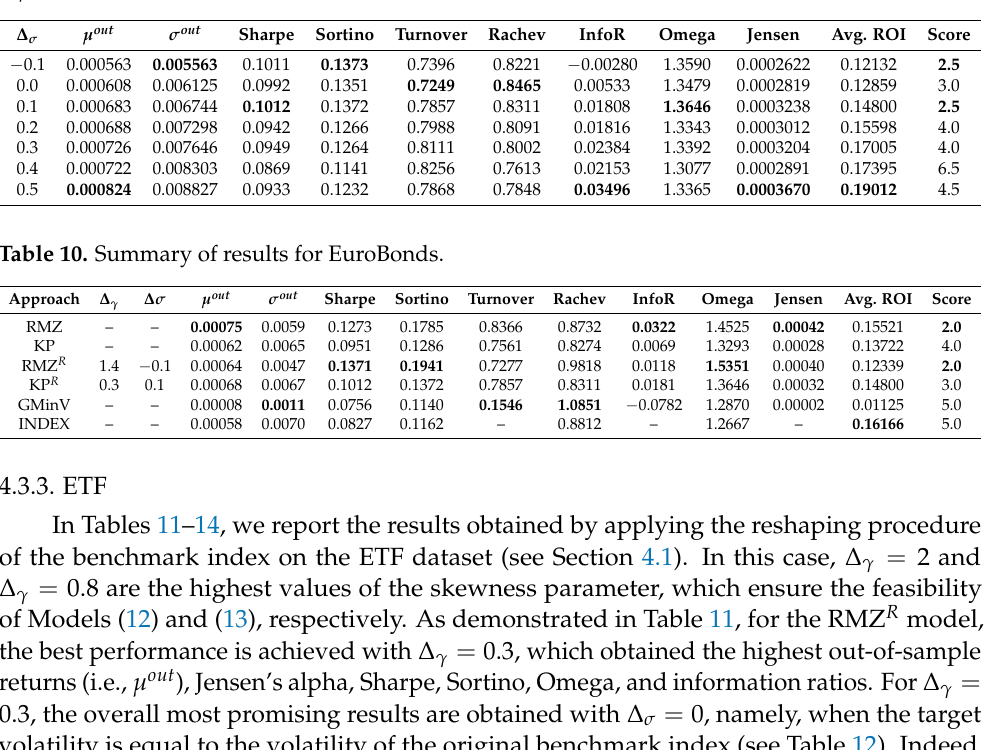
Table 9. EuroBonds: out-of-sample performance results for the KP R strategy by varying ∆ σ (with ∆ γ = 0.3).